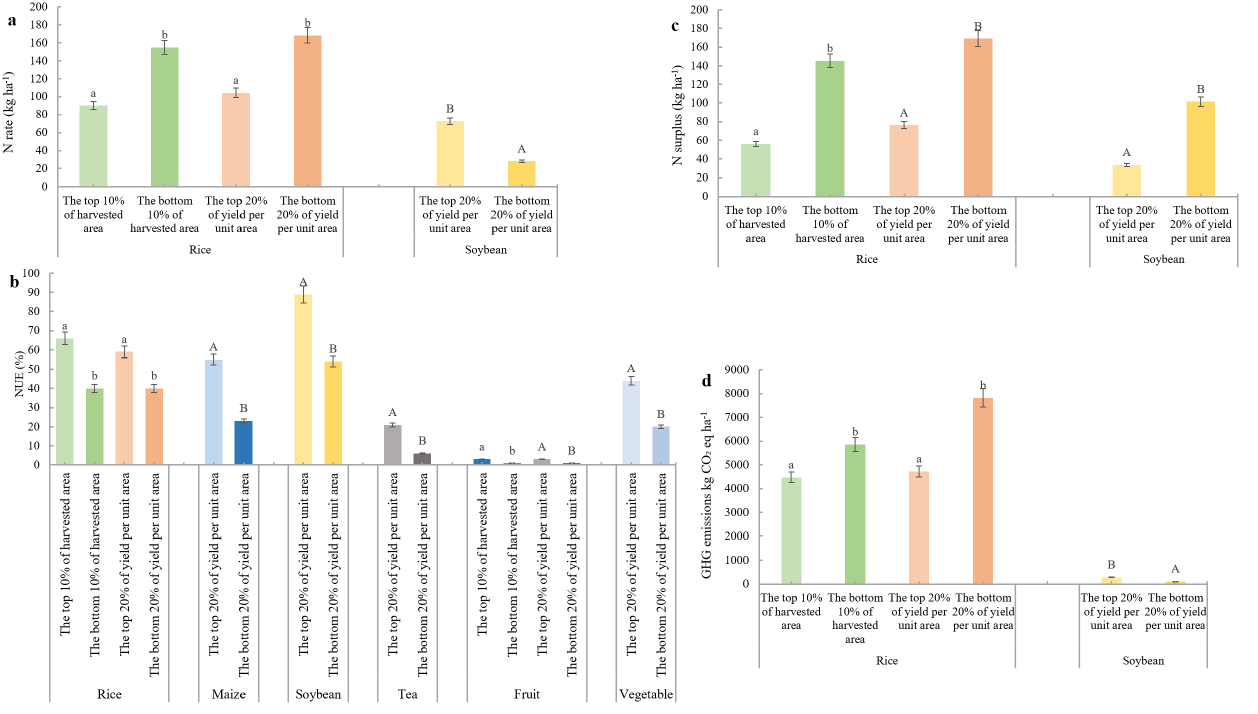
Figure 4. Comparisons of N rate ( a ), NUE ( b ), N surplus ( c ), and GHG emissions ( d ) between counties in the top 10% and bottom 10% by harvested area as well as counties in the top 20% and bottom 20% by yield per unit area in Fujian Province. The a and b represent significance ( p < 0.05), and the A and B represent highly significant ( p < 0.01).